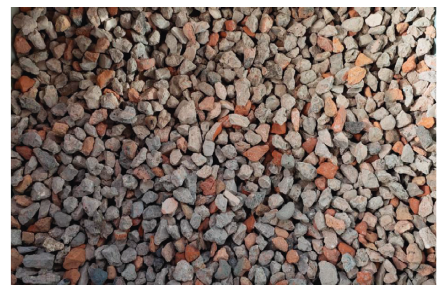
Figure 1: Mixed recycled aggregate.